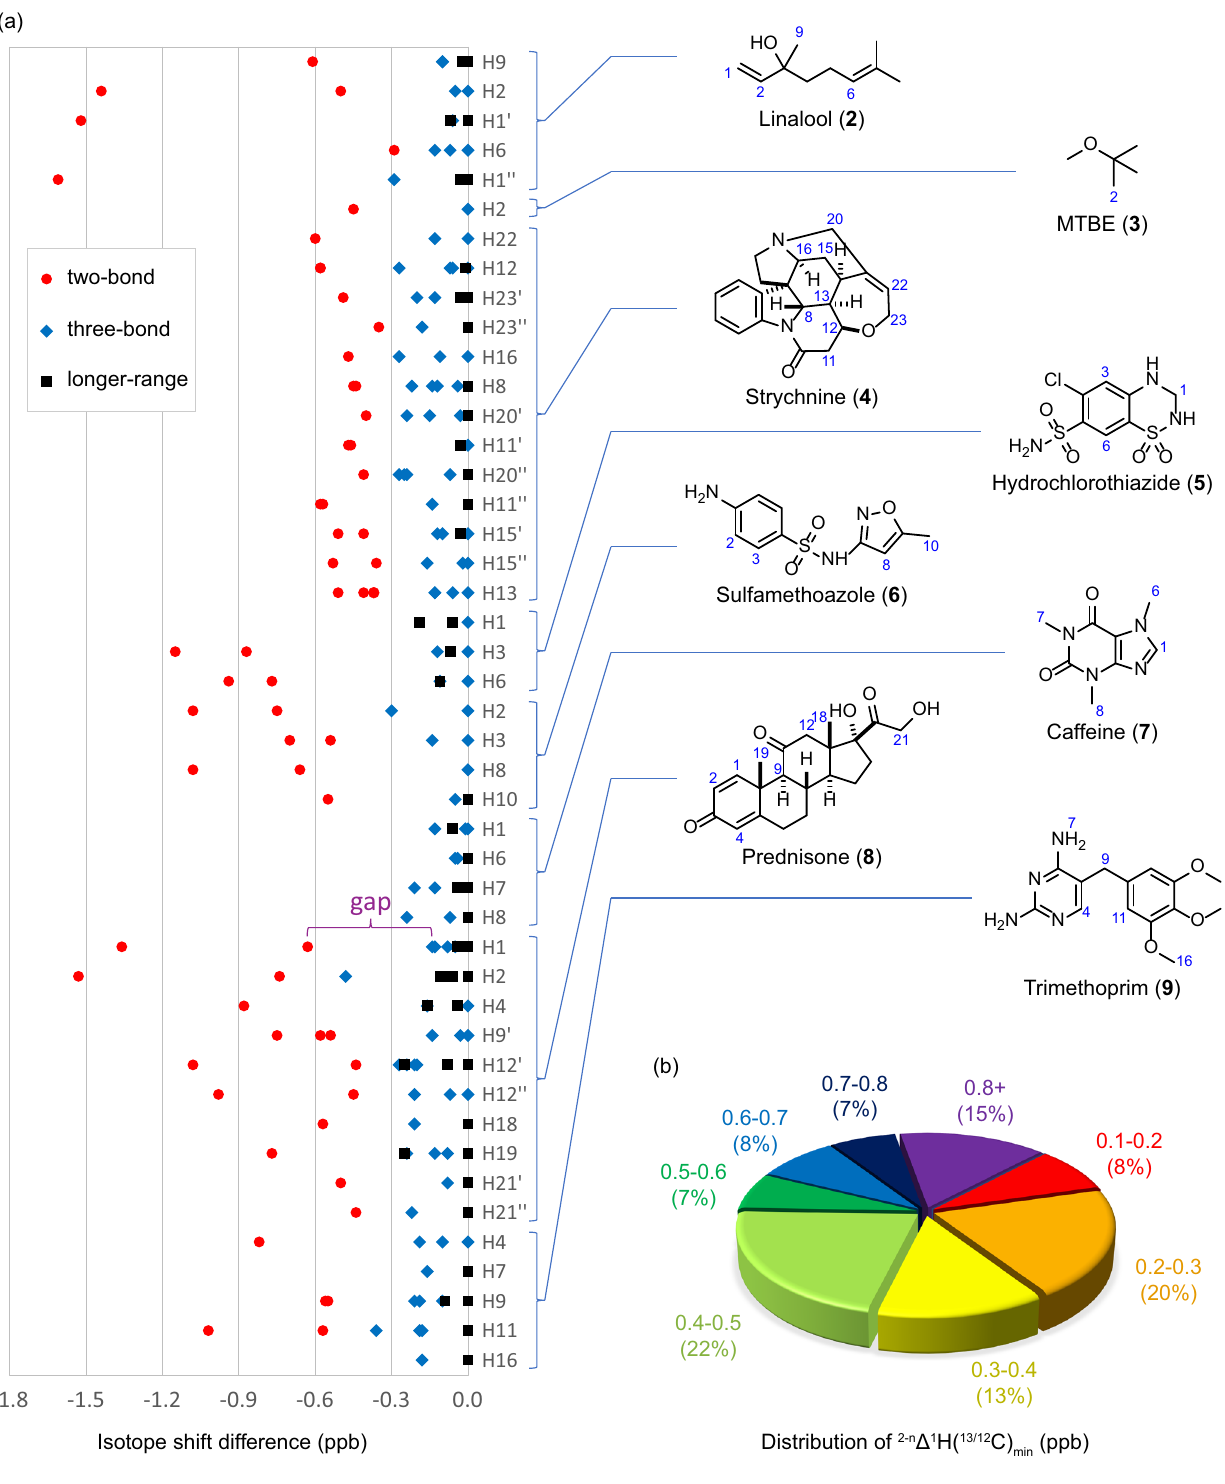
Fig. 4 | Isotope shift differences observed in natural products and pharma- ceuticals.a Measured isotope shift differencein 2 - 9 . b Distribution of magnitudes